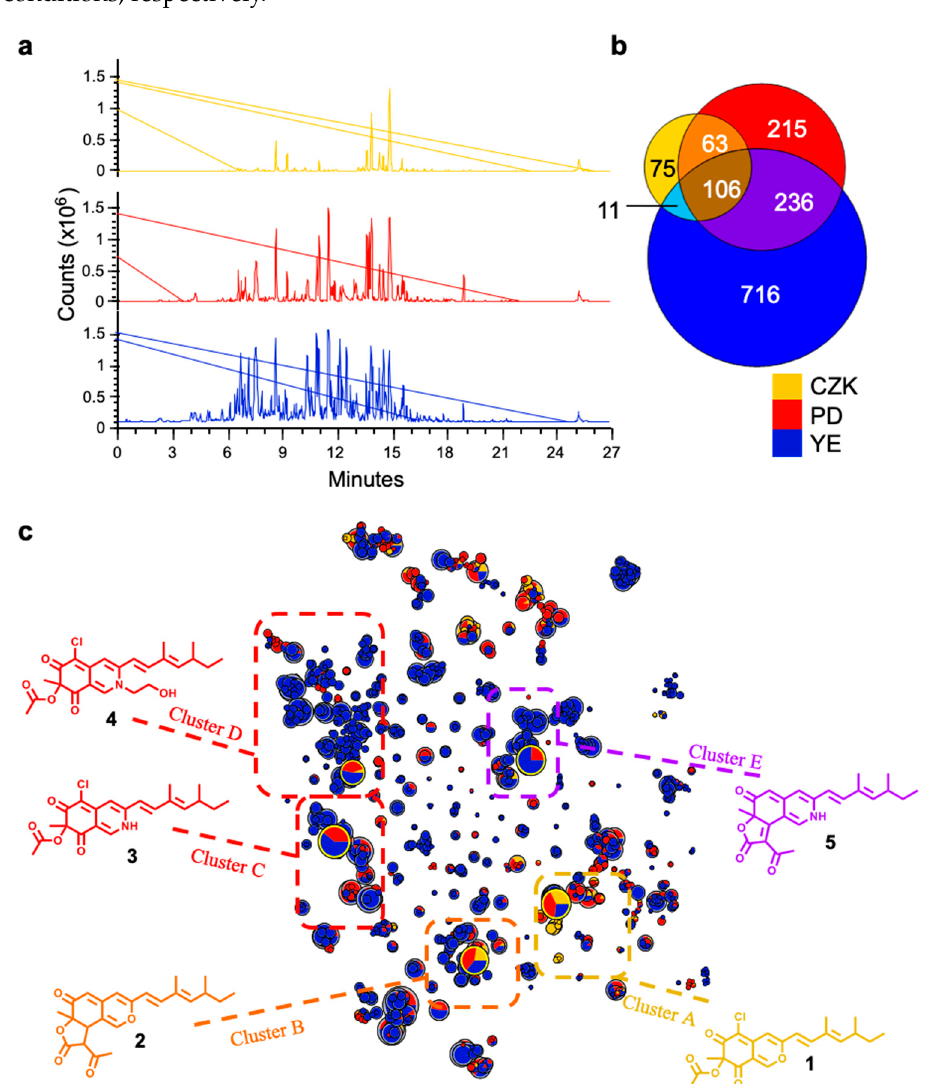
Figure 1. Azaphilone diversity from P. sclerotiorum SNB-CN111 crude extracts induced by an increase in organic nitrogen complexity in the solid medium from CZK medium (yellow, no organic nitrogen), PD medium (red, medium organic nitrogen complexity) to YE (blue, high organic complexity). ( a ) Metabolic profile from RPLC-ESI(+)-MS/MS analysis of crude extracts (TIC values). ( b ) Shared and unique features between metabolic profile of P. sclerotiorum SNB-CN111 cultivation on solid CZK, PD and YE medium. ( c ) t-SNE molecular network representation constructed on MS/MS features homology with the size of node related to their intensity and color of the node to cultivation medium with dereplicated features and structure related to their pigment color. Standards 1 , 2 , 3 , 4 and 5 previously isolated [25] are circled in